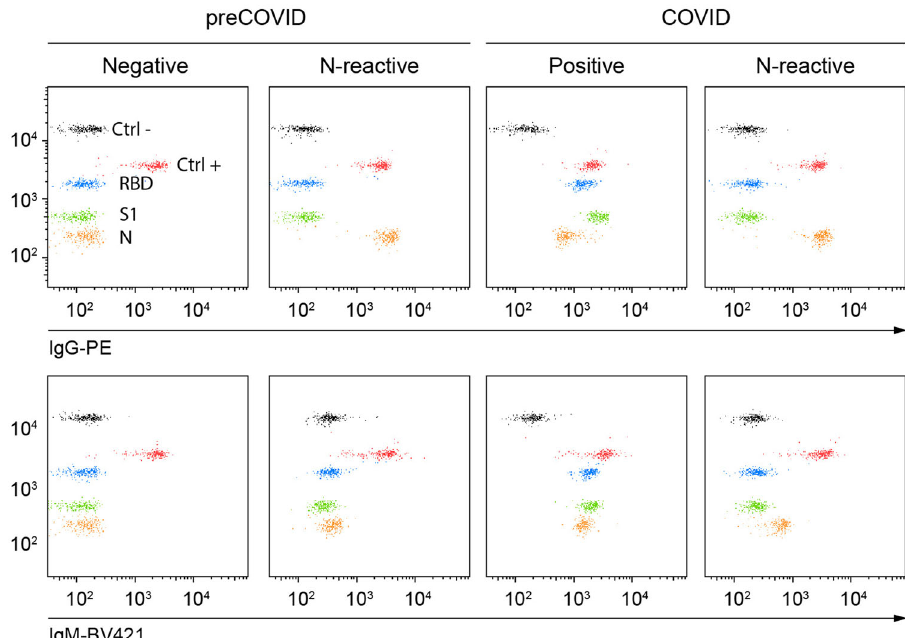
Fig. 4 C19BA reveals different serology patterns in preCOVID and COVID samples collected at time of hospital admission (PCR + ). Dot plots showing IgG (top) and IgM (bottom) reactivity against RBD, S1, and N for representative preCOVID and COVID